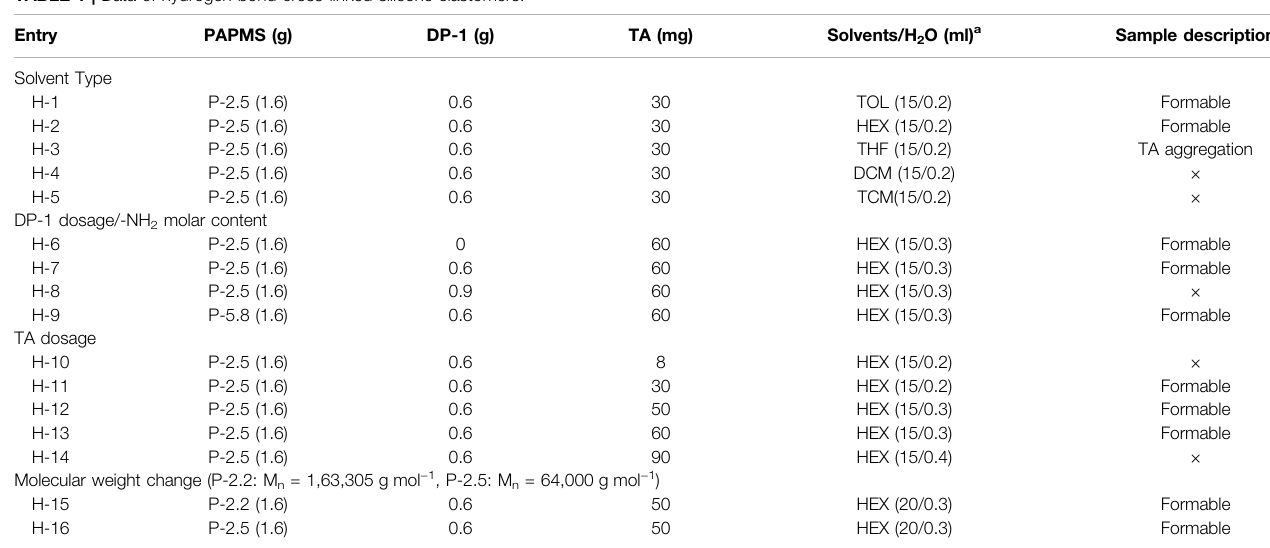
TABLE 1 | Data of hydrogen bond cross-linked silicone elastomers. PAPMS (g) DP-1 (g) Solvents/H 2 O (ml)